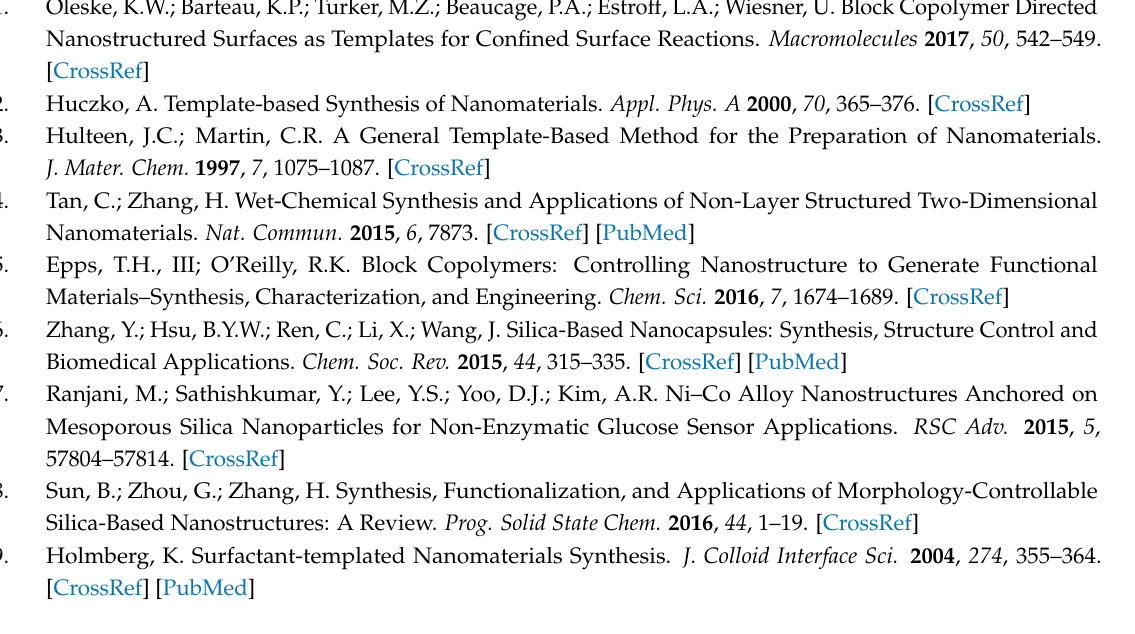
Figure S1. Benedict’s test ( a ) Hydrolysis of rice starch (HRS in dark pale); and ( b ) HRS on Benedict’s solution (Brick’s red). Figure S2. Spectrophotometric determination of Benedict’s solution. Figure S3. Molecular-sized based on computer assisted modeling of molecular mechanics-2 (MM2) modeling of D -glucose. Figure S4. Field emission scanning electron microscopy with energy dispersive X-ray (FESEM-EDX) measurements ( a ) Micrograph of selected image; and ( b ) Energy dispersive X-ray (EDX) spectrum collected from